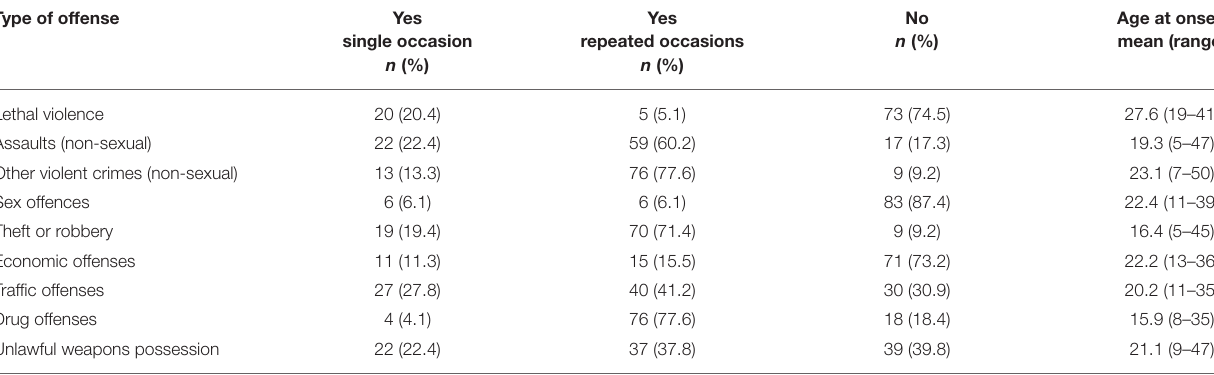
TABLE 2 | Criminological characteristics of forensic psychiatric patients.